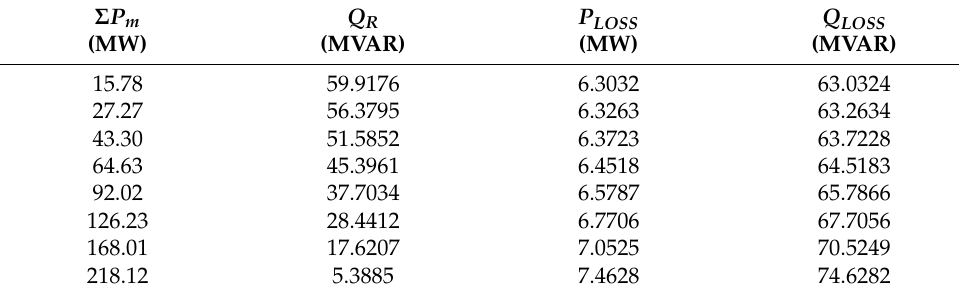
Table 14. DFIG reactive power and losses (PF = 0.95